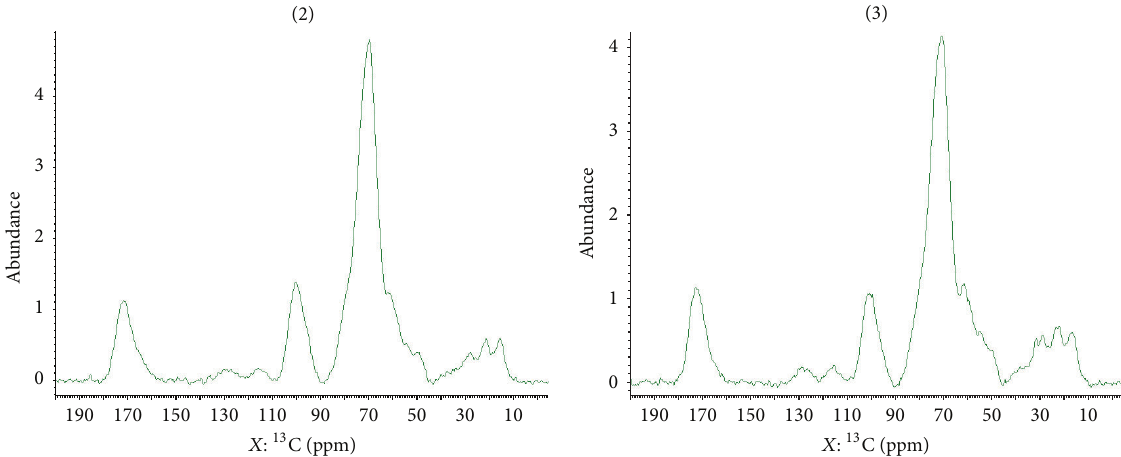
Figure 4: 13 C NMR spectra of FAs isolated from Arctic soils; numbers are the same as those in Figure